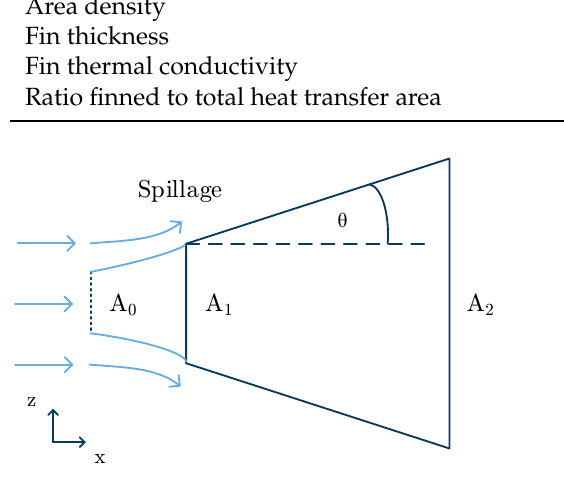
Figure 3. Diffuser